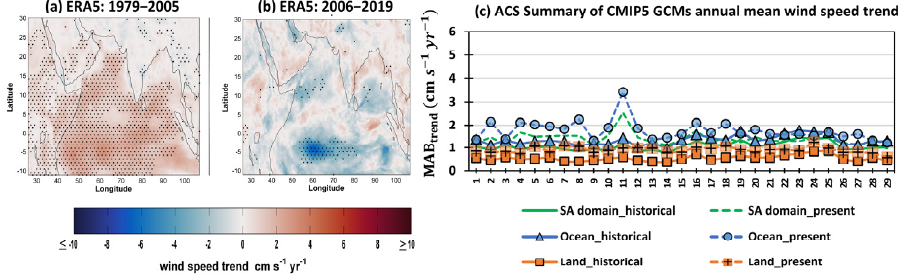
Figure 8. As in Figure 6, but for the annual mean wind speed